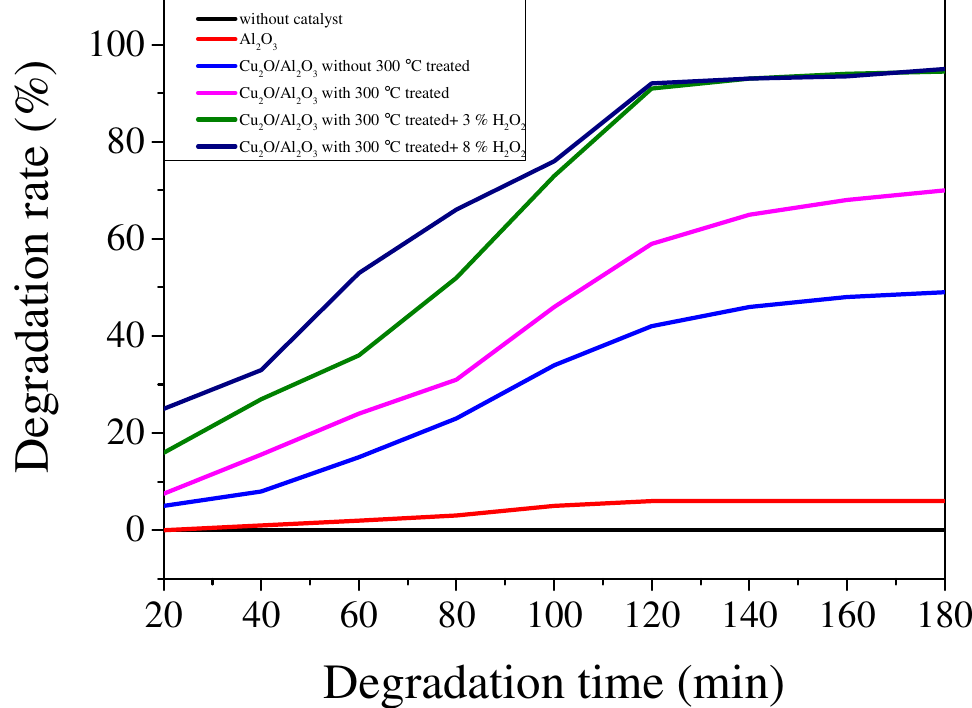
Figure 5. Degradation rate comparison of methyl orange by different coatings. Based on the above research, using H 2 O 2 with a concentration of 3 wt.% as the oxidant, and the Cu 2 O/Al 2 O 3 coating as the catalyst, methyl orange can be degraded within 120 min. However, the effect of process parameters, such as load mass of Cu (I) oxide, degradation temperature, catalyst dosages, and stability was not clear. To study the suitable degradation condition of methyl orange in the process of CWPO, the influence of the above parameters was investigated, and results are presented in Figure 6. It can be seen from Figure 6a that within 30 min, the absorbance of methyl orange decreased with the increase of electrochemical deposition time. When the electrochemical deposition time increased to 35 min, the absorbance decreased. In addition, it can be seen from Figure 6b that the absorbance of methyl orange at 25 ◦ C was lower than that at 15 ◦ C and 40 ◦ C. Figure 6c shows that the absorbance of methyl orange decreased with an increased catalyst dosage from 3 to 8 g, and when the catalyst increased to 10 g, the absorbance of methyl orange was maintained. Moreover, Figure 6d illustrates that the absorbance of methyl orange gradually increased with increasing of catalyst reuse times. According to the absorbance of methyl orange solution is linearly related to its concentration. Compared with the initial methyl orange solution, its absorbance decreased by different degrees with different deposition times, catalytic temperature, and catalyst dosage. The smaller the absorbance, the higher the degradation efficiency of the Cu 2 O/Al 2 O 3 coating. To further study the influence of catalytic condition on the degradation rate of methyl orange, the degradation rate of methyl orange at different conditions was investigated. Results are shown in Figure